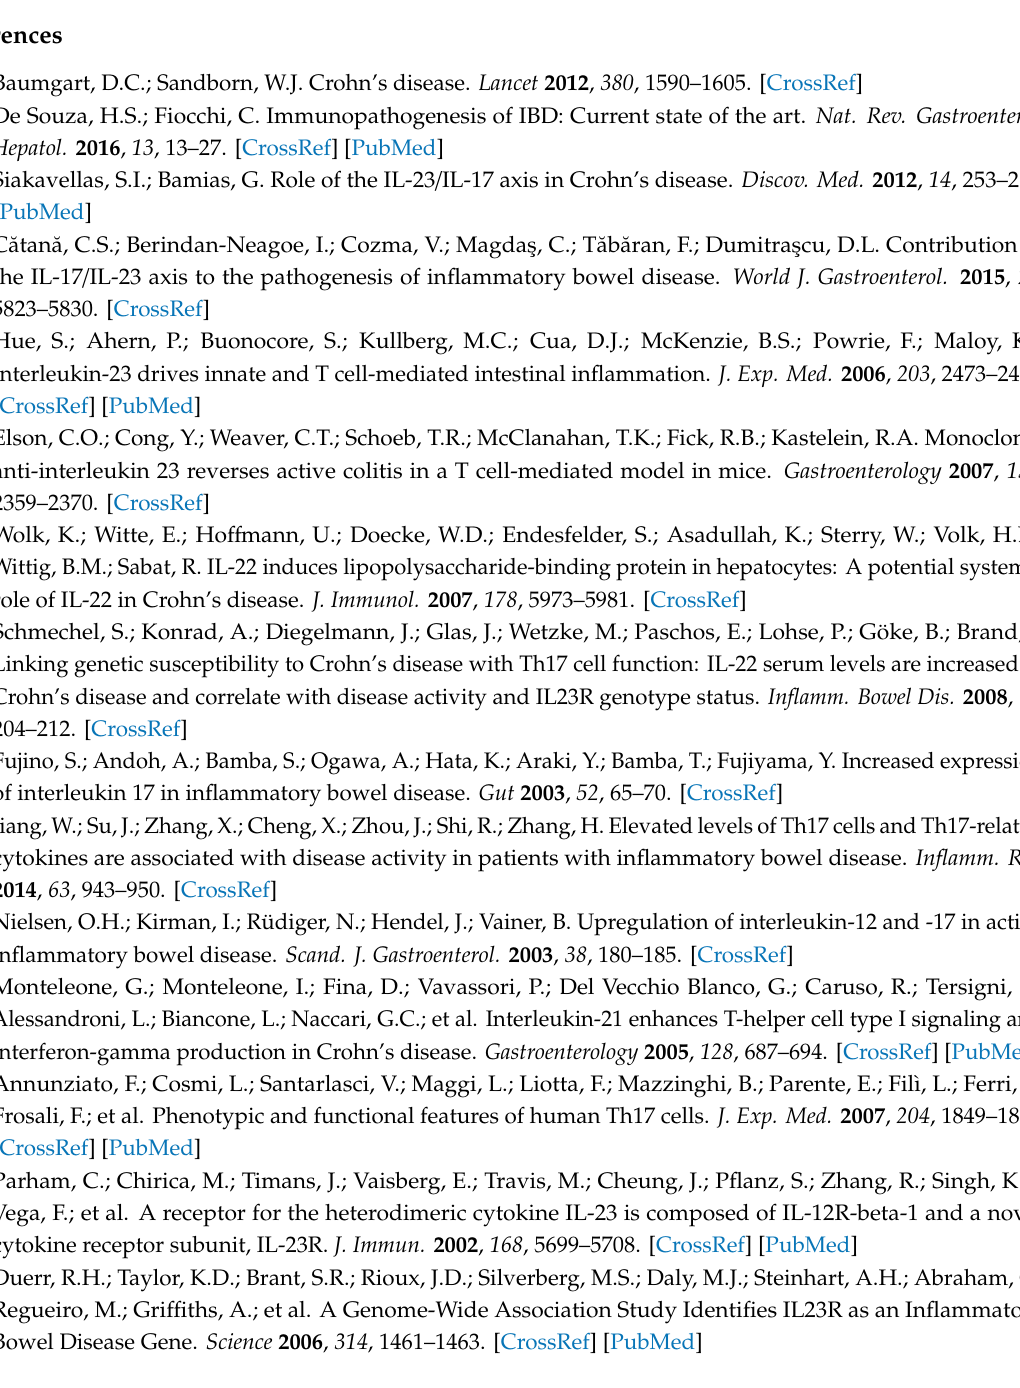
Table S1: Genotype and allele frequencies in subgroups of the Polish and Bosnian CD patients and association between genetic variants of IL23R and CD